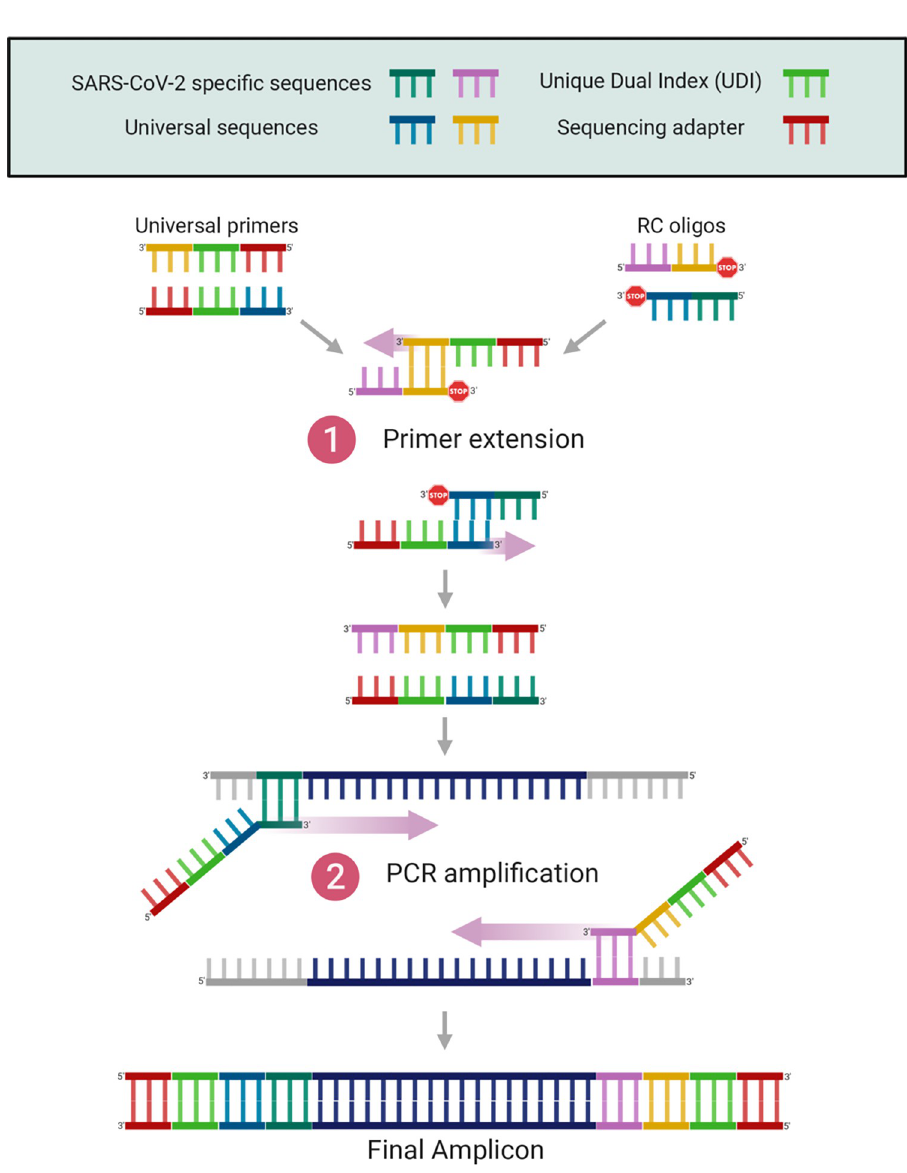
Fig 10. Schematic describing the reverse complement PCR method. Created with Biorender.com, based on adaptation from Coolen et al. (2021).